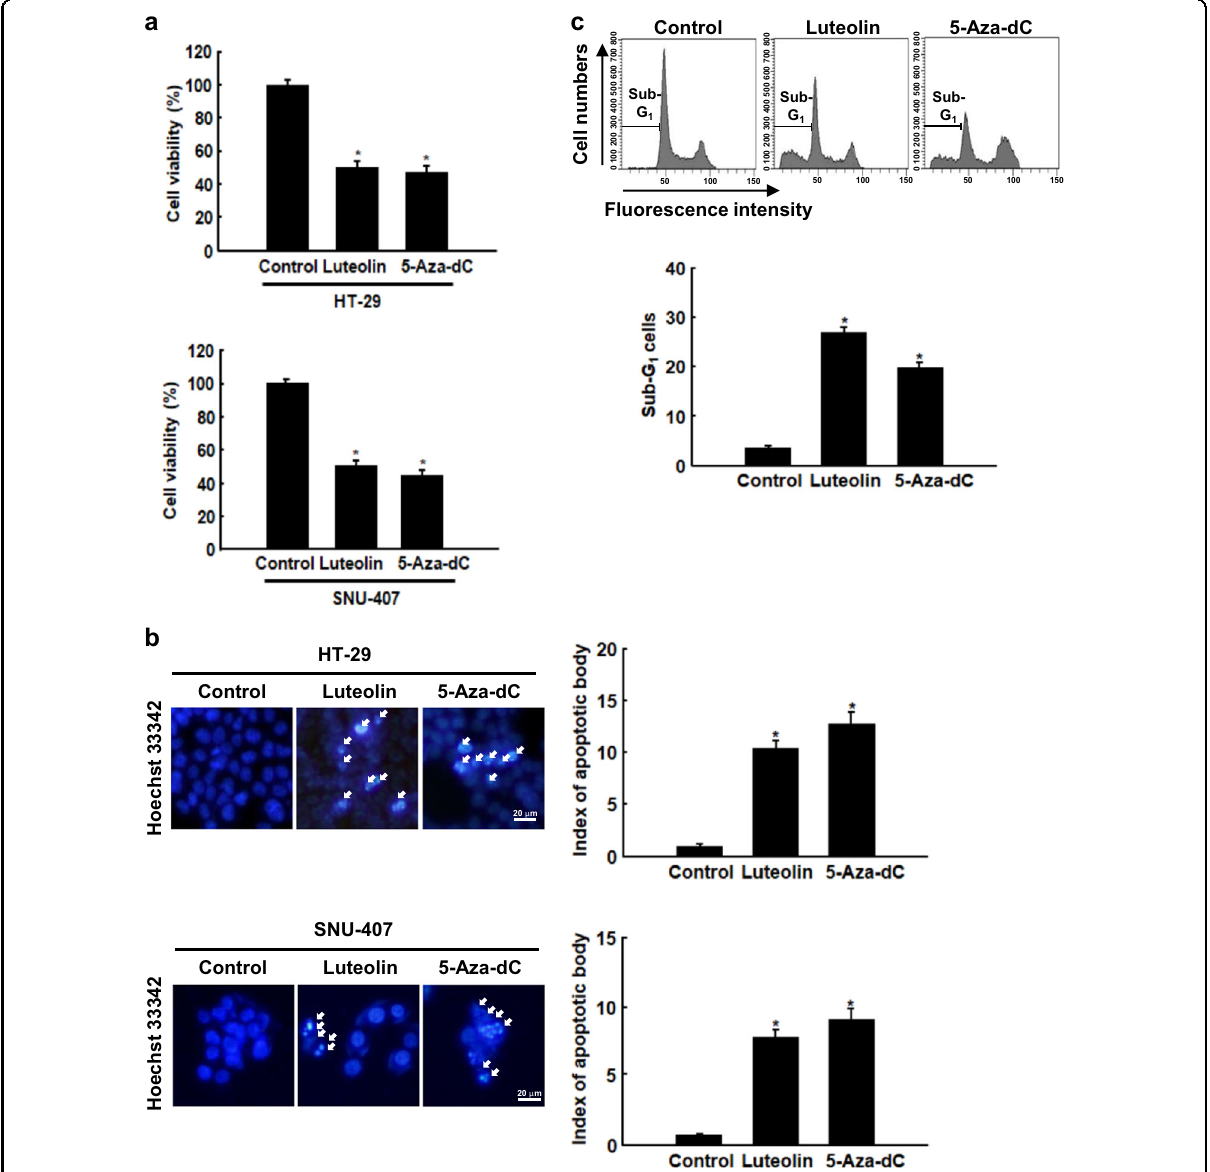
Fig. 3 Luteolin exhibits cytotoxicity similar to DNA methylation inhibitor. Cells were treated with 30 μ M luteolin or 3.5 μ M 5-aza-dC for 48 h. a The viability of cells treated with 5-aza-dC and luteolin was determined using the MTT assay; * p < 0.05 compared with control cells. b Apoptotic body formation was observed using a fl uorescence microscope after cells were stained with Hoechst 33342. Arrows indicate apoptotic bodies; * p < 0.05 compared with control cells. c Apoptotic sub-G 1 DNA content was detected using fl ow cytometry after the cells were stained with propidium iodide (PI); * p < 0.05 compared with control Luteolin markedly decreased the protein expression of DNMT1, DNMT3A, and DNMT3B, which all add a methyl DNMT1, DNMT3A, and DNMT3B in a dose- and time- group to the C5 position of the cytosine ring of the DNA to dependent manner (Fig. 4a, b). In contrast, it markedly produce 5-methylcytosine (5-mC). DNMT1 mediates increased the protein expression of TET1, TET2, and maintenance DNA methylation, whereas DNMT3a and 3b TET3 in a dose- and time-dependent manner (Fig. 4c, mediate de novo DNA methylation 24 . This methylation d). Furthermore, the TET activity was assessed by process is reversible by DNA demethylases, TET1, TET2, measuring the 5-hmC levels, which were higher in the and TET3. These enzymes convert 5-mC to 5-hmC, 5- luteolin-treated cells than in the control cells (Fig. 4e). formylcytosine (5-fC), and 5-carboxylcytosine (5-caC), ultimately generating cytosine 25 .